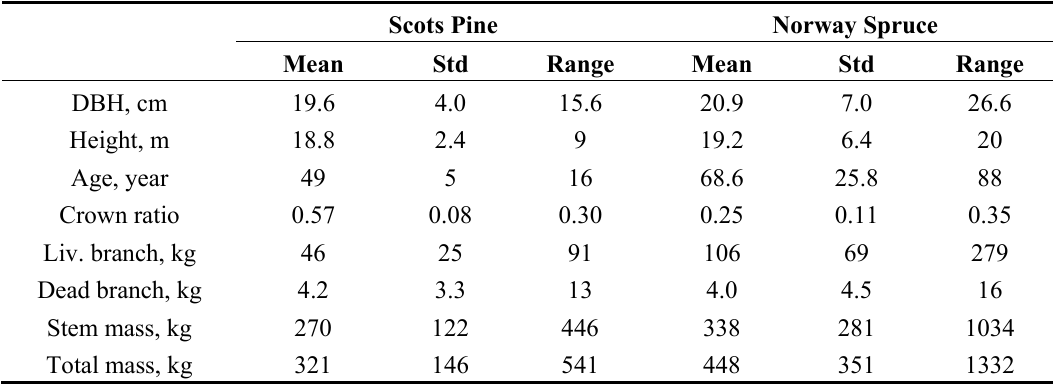
Table 3. Sample tree statistics for evaluation of Repola [42]